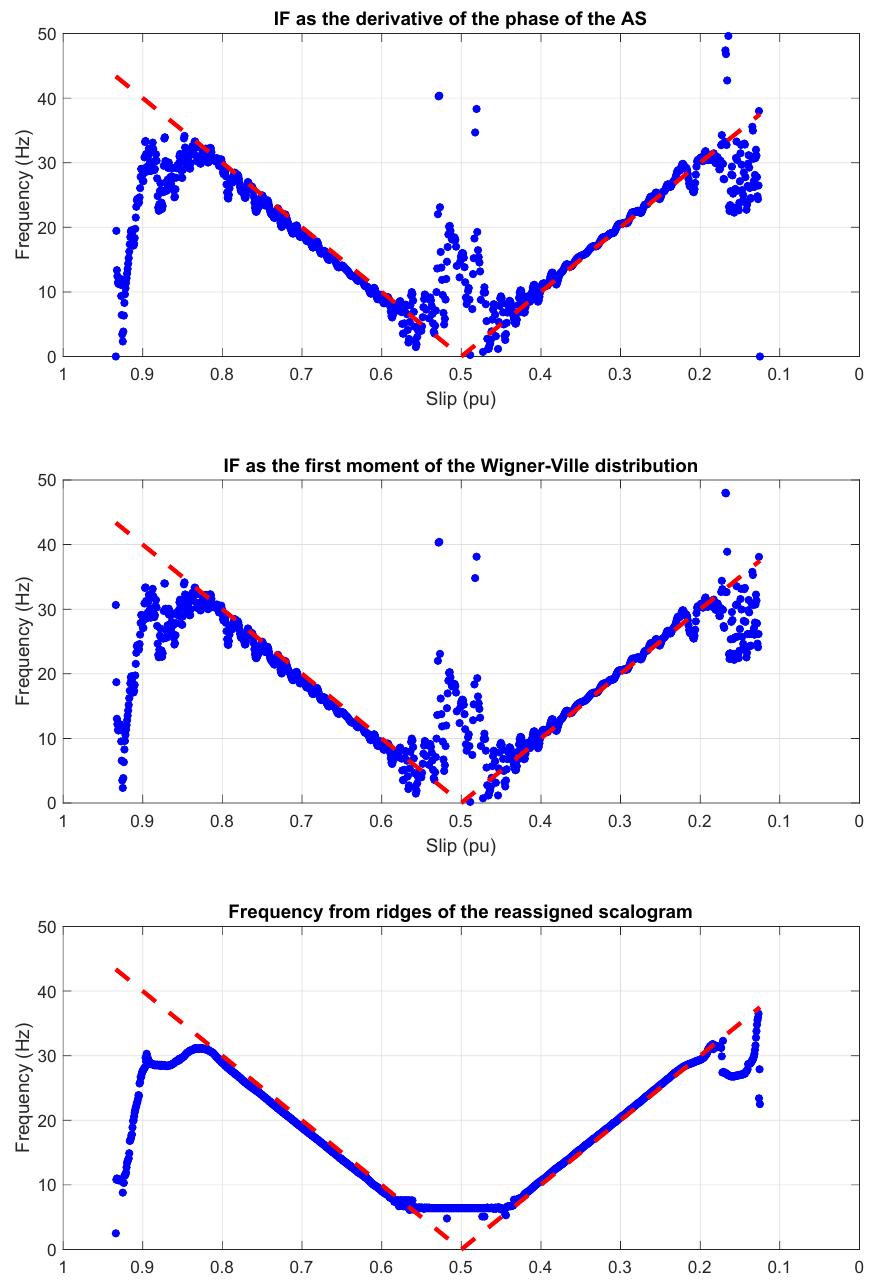
Figure 11. IF of the experimental LSHst computed using (from top to bottom): Hilbert transform, Wigner–Ville distribution and the reassigned scalogram based on the CWT. Dashed, red line: theoretical evolution of the fault harmonic. Dotted, blue line: evolution of the fault harmonic of the tested